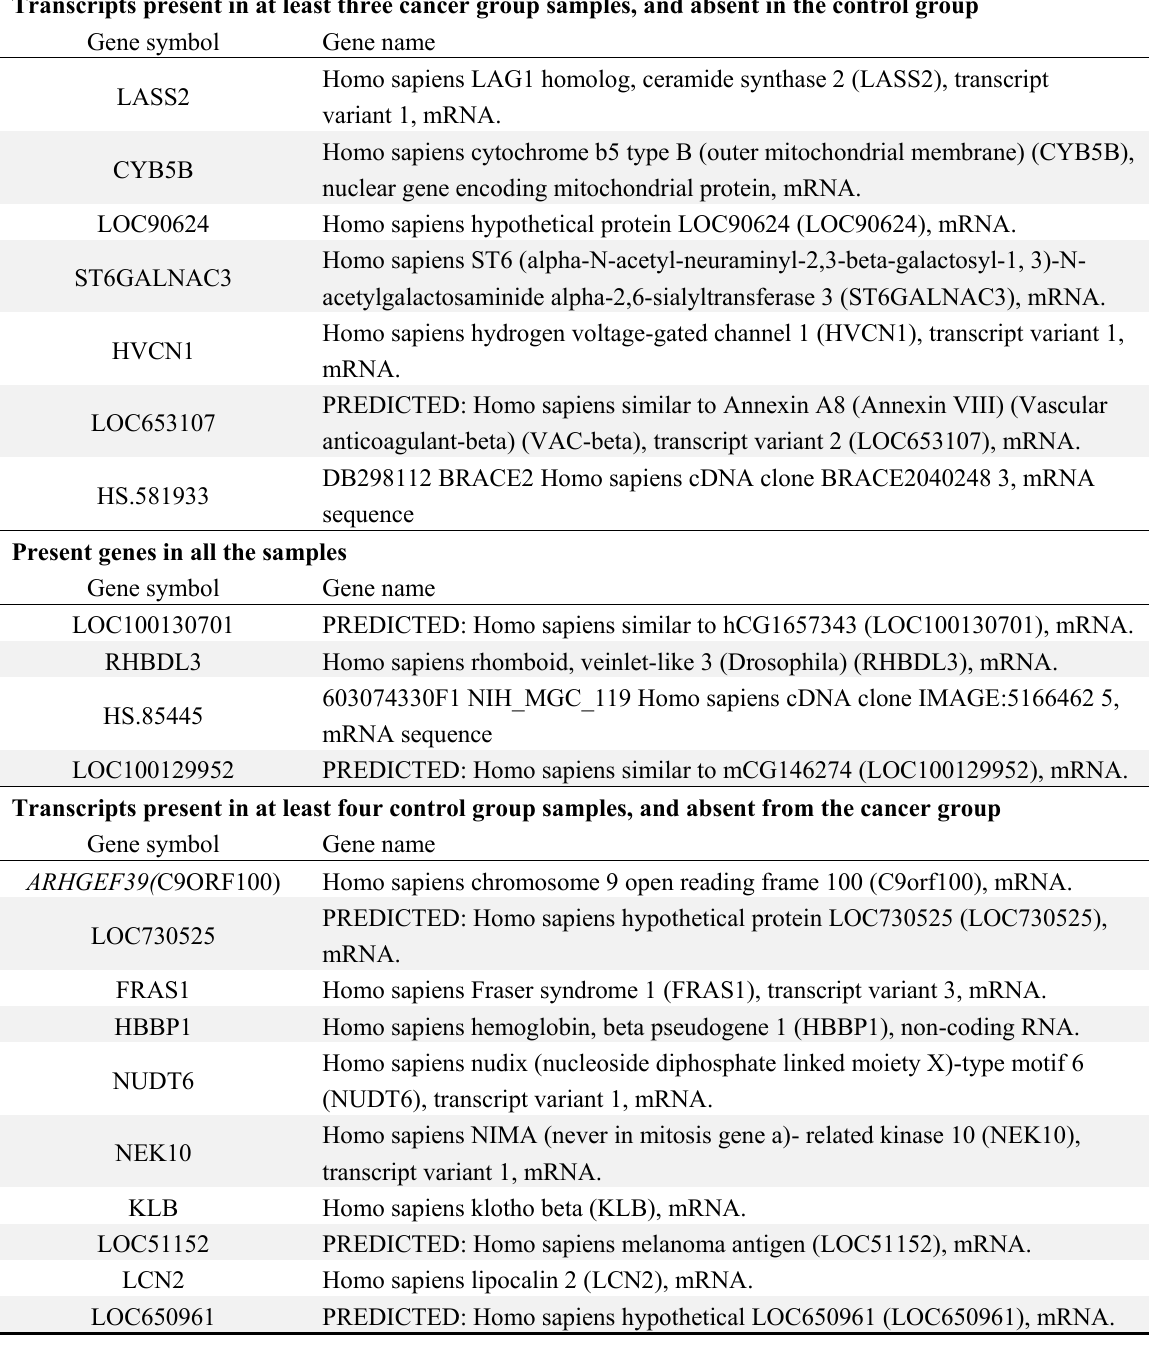
Table 1. List of the genes that were found in at least four samples of control group and absent from cancer group, and those genes present in at least three samples from cancer group, and absent from control group. The list of genes detected in all the samples of the array is also